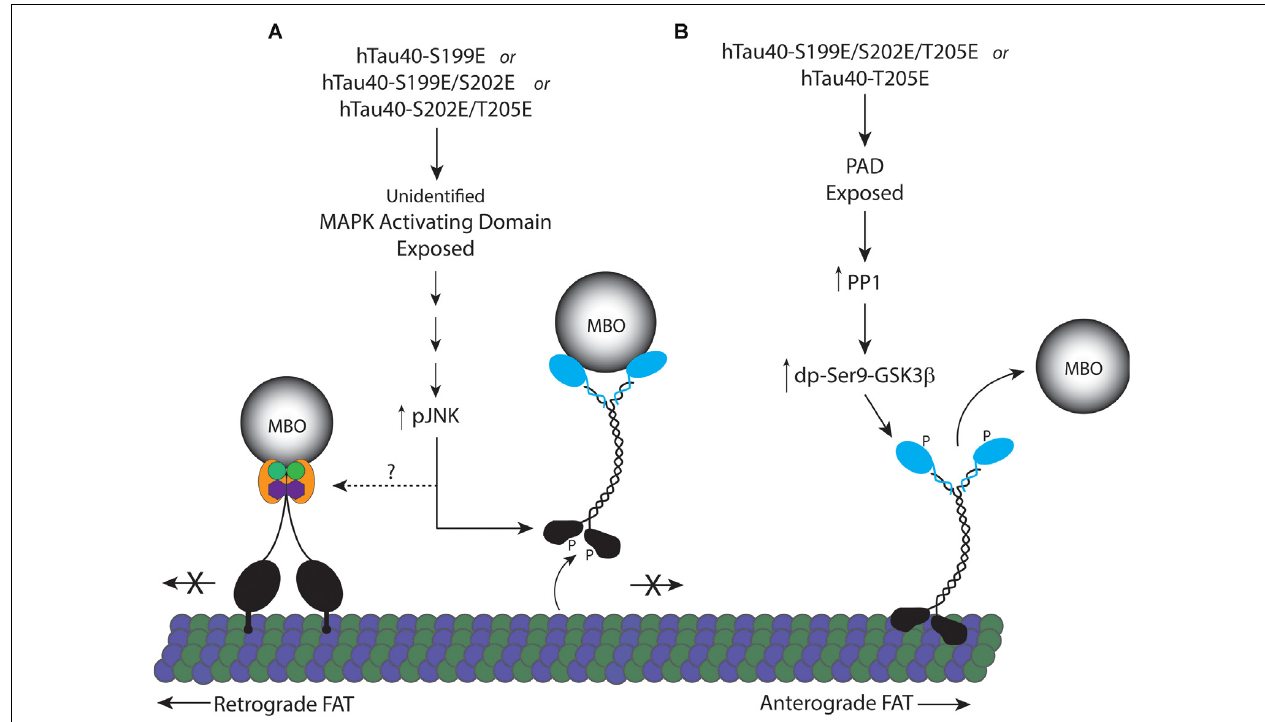
FIGURE 6 | Proposed model for inhibition of FAT by pseudophosphorylated tau proteins. (A) Tau monomers individually pseudophosphorylated at S199 (hTau40-S199E), or doubly pseudophosphorylated at S199 and S202 (hTau40-S199E/S202E), or S202 and T205 (hTau40-S202E/T205E) fold into a conformation that exposes an unidentified MAPK activating domain leading to activation of pJNKs which can directly phosphorylate kinesin-1 heavy chain subunits inhibiting their association with microtubules (Morfini et al., 2009b). JNK3 also inhibits retrograde FAT through an unknown mechanism. (B) Pseudophosphorylation of tau monomers at T205 (hTau40-T205E) or S199, S202 and T205 (hTau40-S199E/S202E/T205E; Kanaan et al., 2011) fold into a conformation that exposes the N-terminal PAD resulting in activation of a PP1/GSK3 β signaling cascade that phosphorylates kinesin light chain ending in release of the cargo from